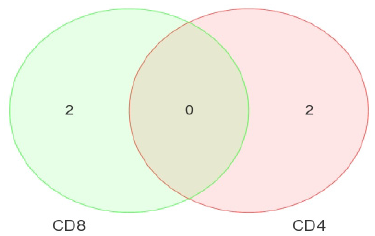
Figure 5. Venn diagram showing miRNAs specific to CD4+ and CD8+ T-cells with the absence of any overlapping miRNAs between these two cell types. Uninfected n = 3, and HIV-infected n = 15. Table 2. DE miRNAs in HIV infected CD4+ and CD8+ T-cells using the false discovery rate (FDR) method. Cell Type miRNA